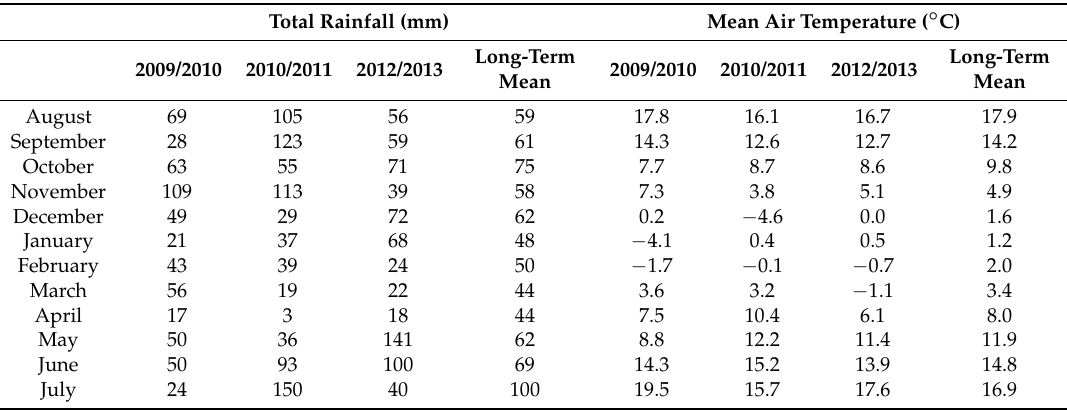
Table 5. Monthly rainfall (mm) and mean air temperature ( ◦ C) at Hohenschulen, Germany. Total Rainfall (mm)